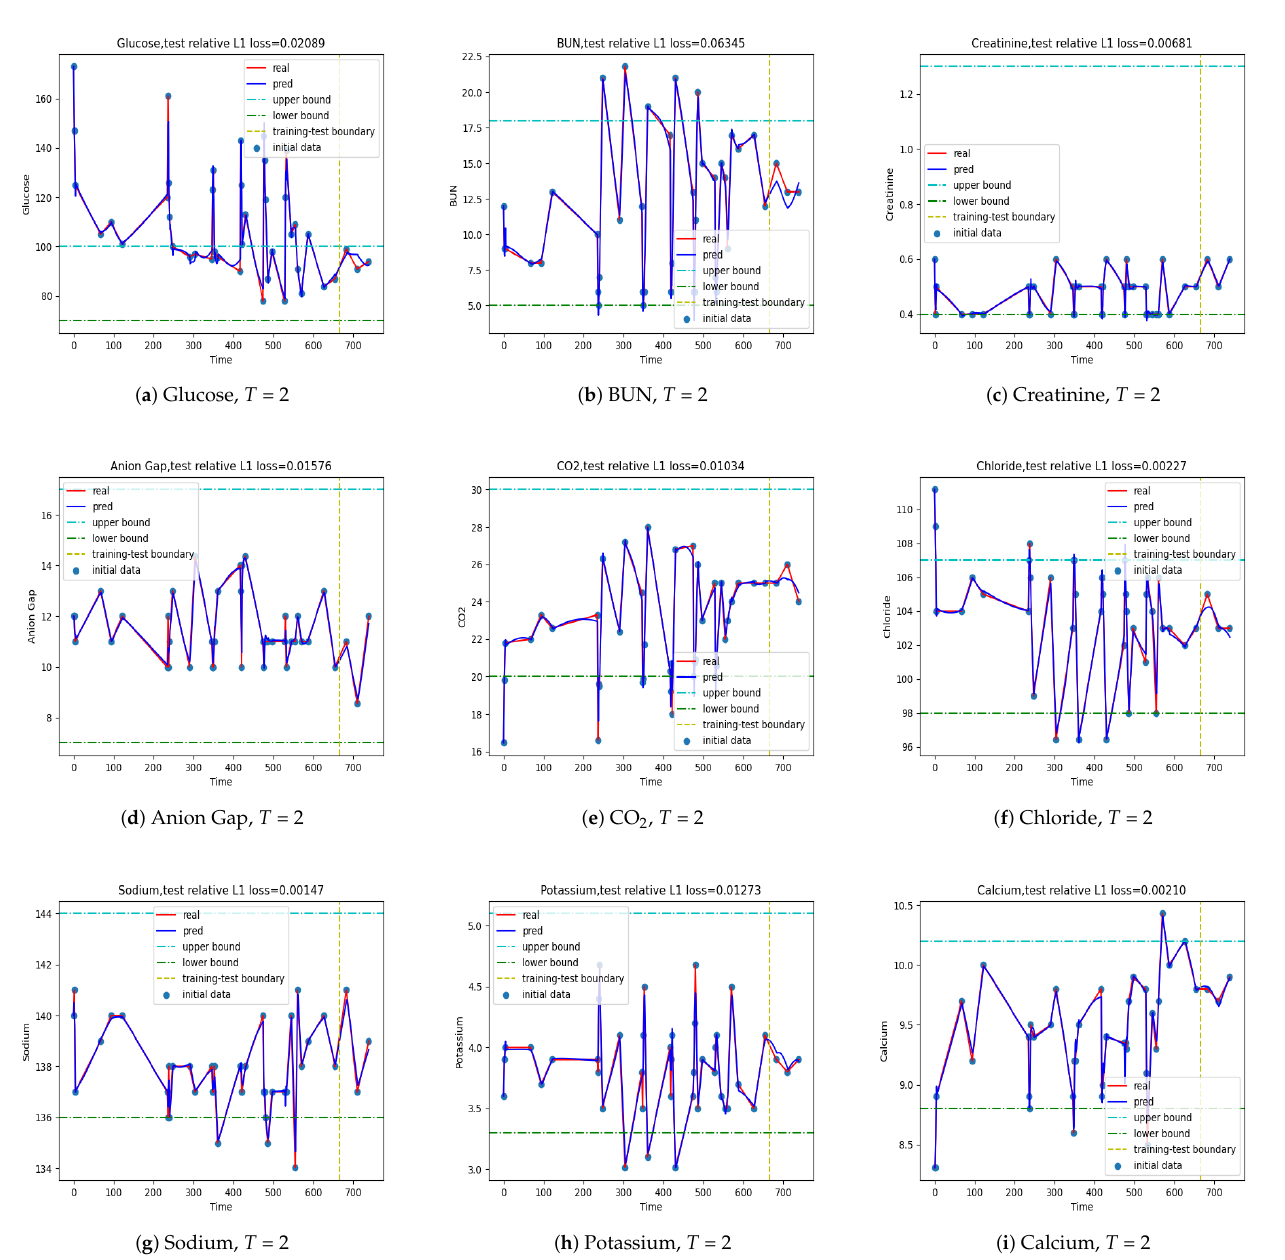
Figure 4. Output { ˆ y i , i = 1, · · · , } of the LSTM with time step T = 2. The values used in training are plotted on the left of the vertical line, while the predicted ones are on the right. The largest L 1 error is about 1.5%, and the largest L ∞ error is about